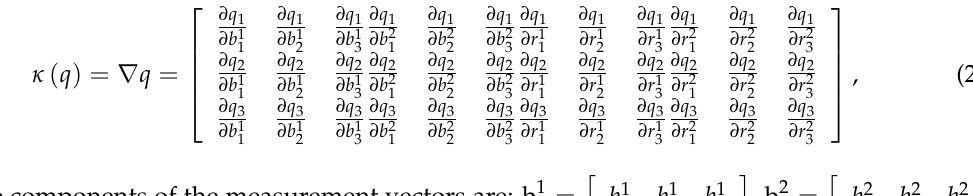
Figure 5. Top plot shows determined (dots) and estimated quaternion (solid) in a simulation with noisy observation vectors. Bottom plot shows simulated (dots) and estimated (solid) angular velocity.